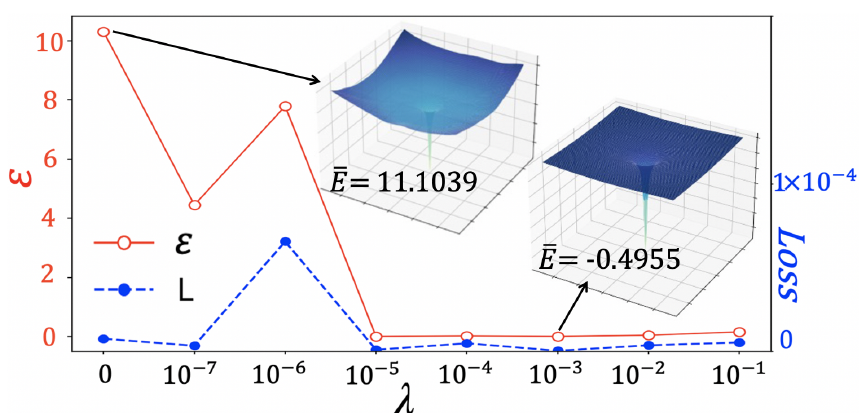
Figure 4: (Color online) The error of the potential [ Eq. (10) ] and the loss [ Eq. (8) ] with different values of the Lagrangian multiplier λ . The insets show two examples of the predicted potential with z = 0. We take the numbers of hidden variables to be the same values as those in Fig.